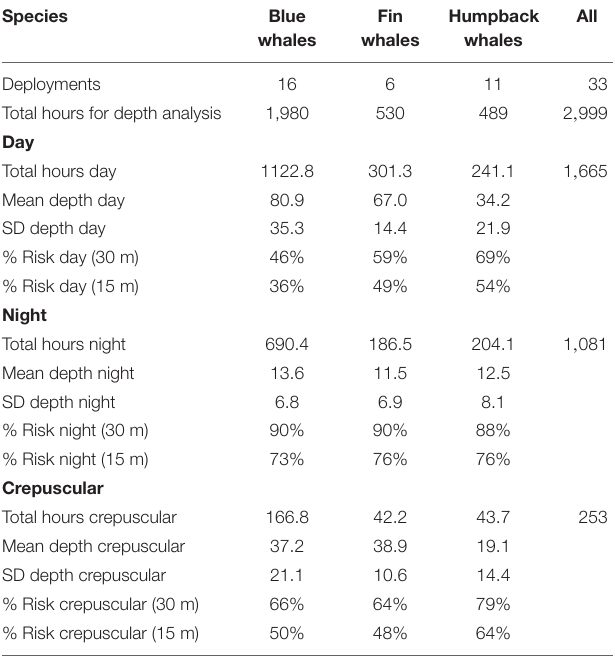
TABLE 2 | Summary of cumulative time at depth by time period and